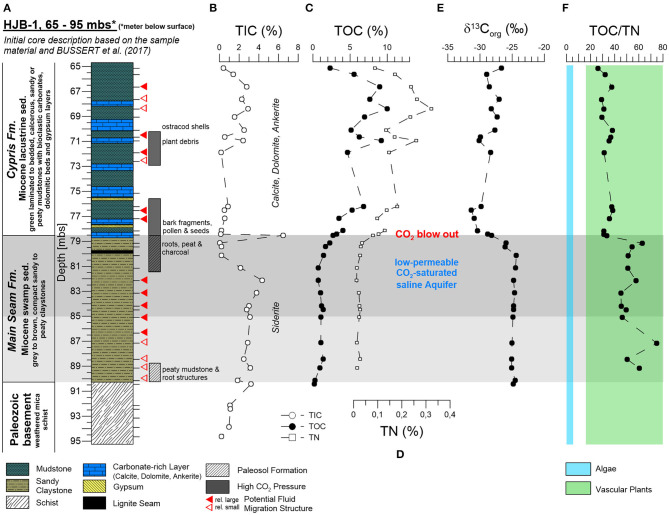
Investigated core section of the Hartoušov mofette core HJB-1 (2016) between 65 and 95 mbs with depth profiles of bulk sedimentological parameters. (A) Stratigraphical and lithological description based on visual inspection of the sample material and on data from Bussert et al. (2017), (B) total inorganic carbon (TIC), (C) total organic carbon (TOC), (D) total nitrogen (TN), (E) bulk δ13Corg, and (F) the TOC/TN ratio.